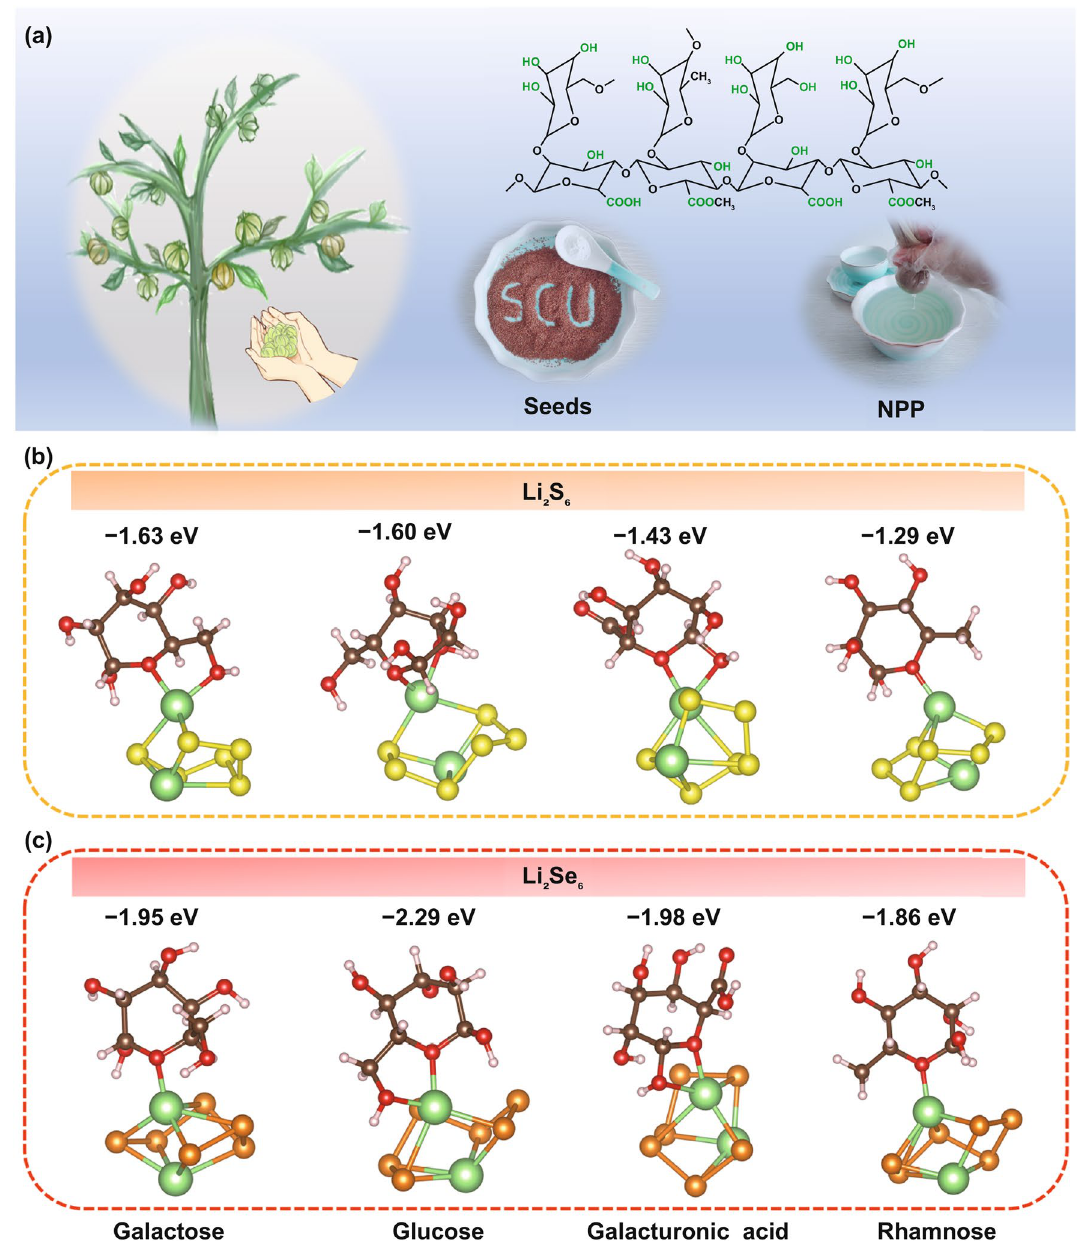
Fig. 1 a Schematic diagram of the extraction process of the NPP. The optimized structures of four typical main components of NPP adsorbed with, b Li 2 S 6 and c Li 2 Se 6 . The selenium, sulfur, oxygen, lithium, carbon and hydrogen are distinguished with orange, yellow, red, green, brown, and white. (Color figure